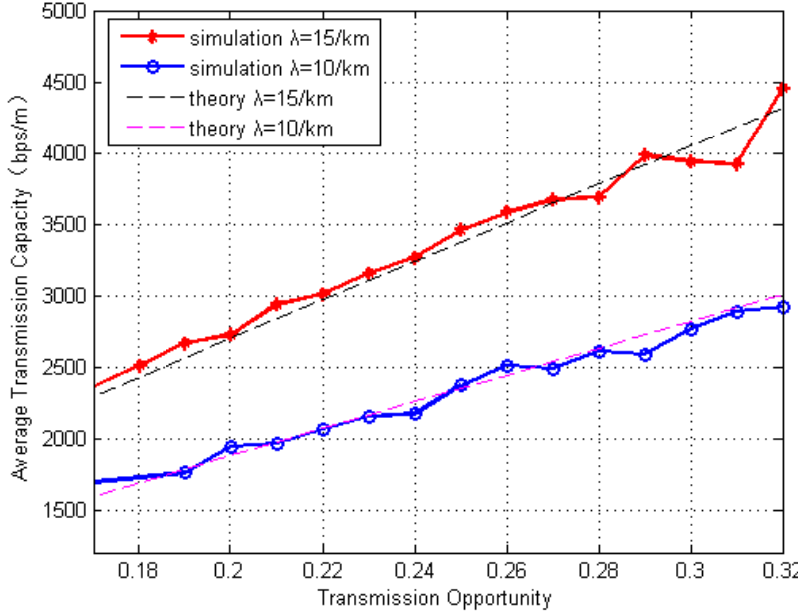
Figure 7. Average transmission capacity with highest priority versus transmission opportunity.